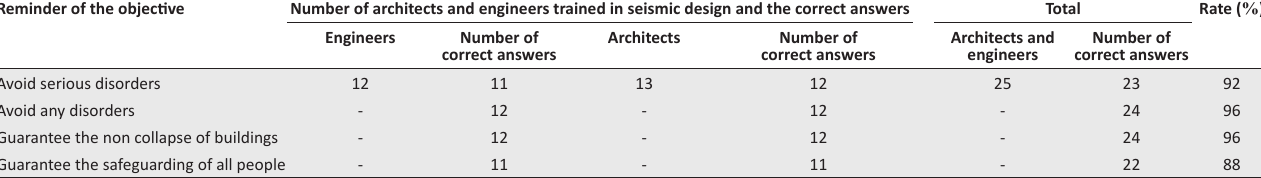
TABLE 10: Seismic training and correct answers for code objectives. Reminder of the objective